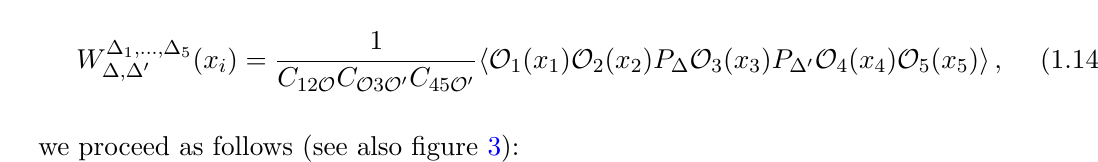
= (cid:1) 1 + (cid:1) 2 + 2 k 1 ; (cid:1) k = (cid:1) 4 + (cid:1) 5 + 2 k 2 . The (cid:12)gure 1 2